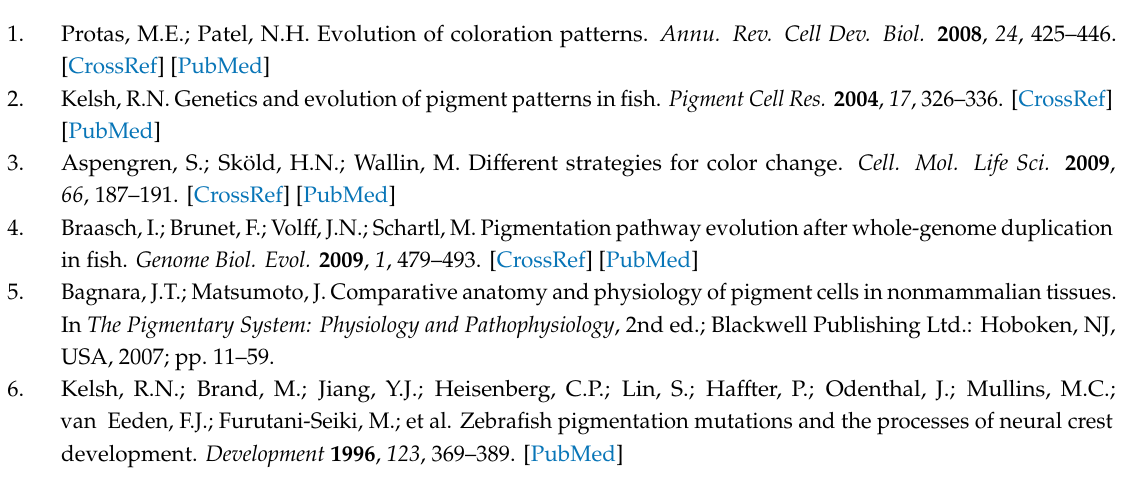
Figure S1: Volcano plot of DEGs and DEMs in TM and WT: (A) Volcano plot of DEGs in TM and WT; (B) Volcano plot of DEMs (known) in TM and WT; (C) Volcano plot of DEMs (novel) in TM and WT. Splashes represent di ff erent genes or miRNAs, and the black splashes mean genes or miRNAs without significant di ff erential expression. The red splashes mean significantly up-regulated genes or miRNAs, and the green splashes mean significantly down-regulated genes or RNAs. Figure S2: GO classification annotation chart: The abscissa represents the three ontologies of GO, which are molecular function, cellular component, and biological process. The ordinate represents the percent of genes and the number of genes. Table S1: Primer sequences. Table S2: Statistic of mRNA data. Table S3: Statistic of miRNA data. Table S4: DE miRNAs in TM compared to WT. Table S5: All the DE genes between TM and